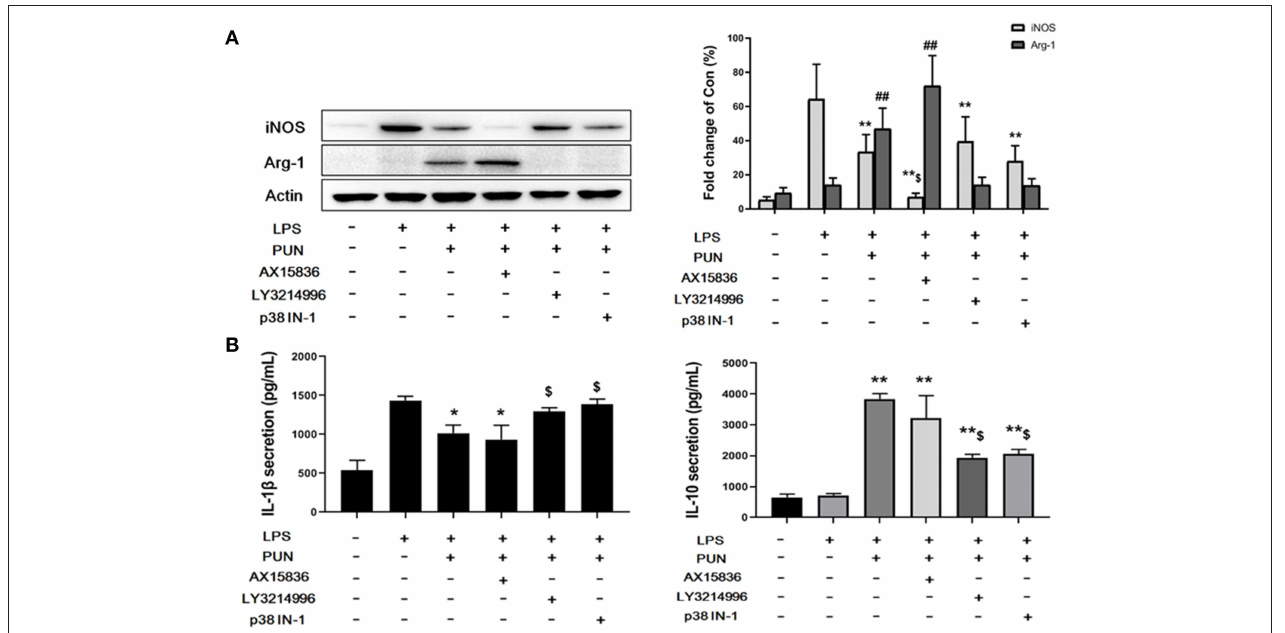
FIGURE 4 | ERK1/2 and p38 are essential to MKP1-mediated macrophage polarization. (A) ERK1/2 and p38 are involved in the expression of iNOS and Arg-1. Cells were pretreated with 20 µ M PUN with desired chemical inhibitors for 3h and then treated with 1 µ g/mL of LPS for 12h, as indicated. The expression of iNOS and Arg-1 were detected by Western blot. Data are expressed as the mean ± SD of three independent experiments. ** p < 0.01 and ## p < 0.01 indicate statistically significant differences compared with the LPS group. $ p < 0.05 indicates statistically significant differences compared with LPS/PUN group. (B) ERK1/2 and p38 are involved in the expression of IL-1 β and IL-10. Cells were pretreated with 20 µ M PUN with the desired chemical inhibitors for 3h and then treated with 1 µ g/mL of LPS for 24h, as indicated. The expression of IL-1 β and IL-10 were detected by ELISA. Data are expressed as mean ± SD of three independent experiments. * p < 0.05, ** p < 0.01 indicate statistically significant differences compared with LPS group. $ p < 0.05 indicates statistically significant differences compared with LPS/PUN group.